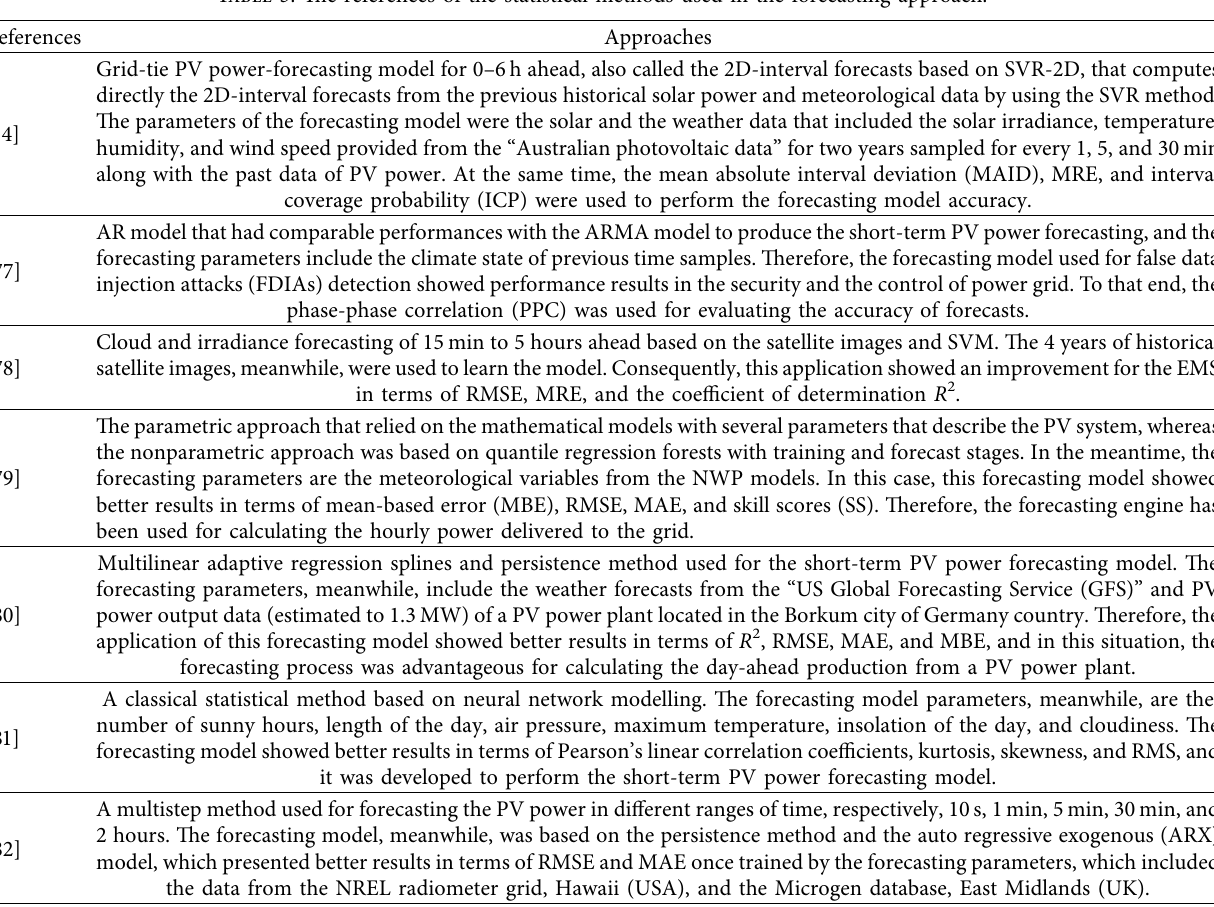
Table 5: The references of the statistical methods used in the forecasting